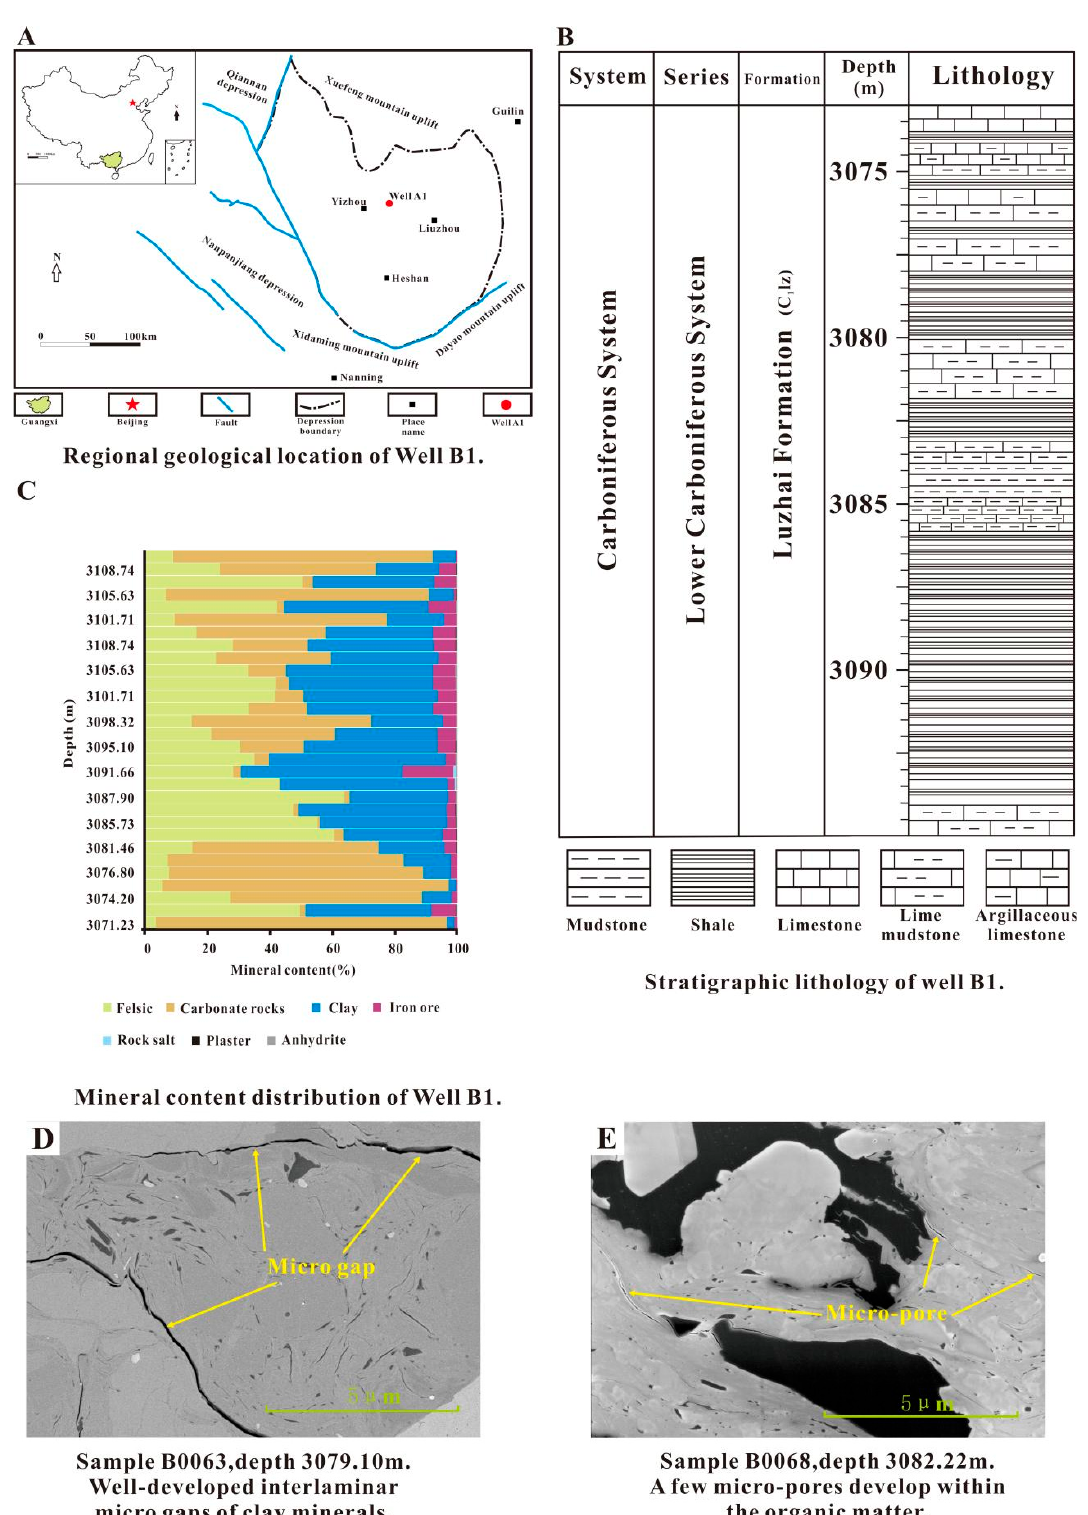
Figure 2. Location ( A ), lithology ( B ), mineral X-ray diffraction ( C ) and argon ion scanning electron microscope ( D , E ) parameters of well B1.